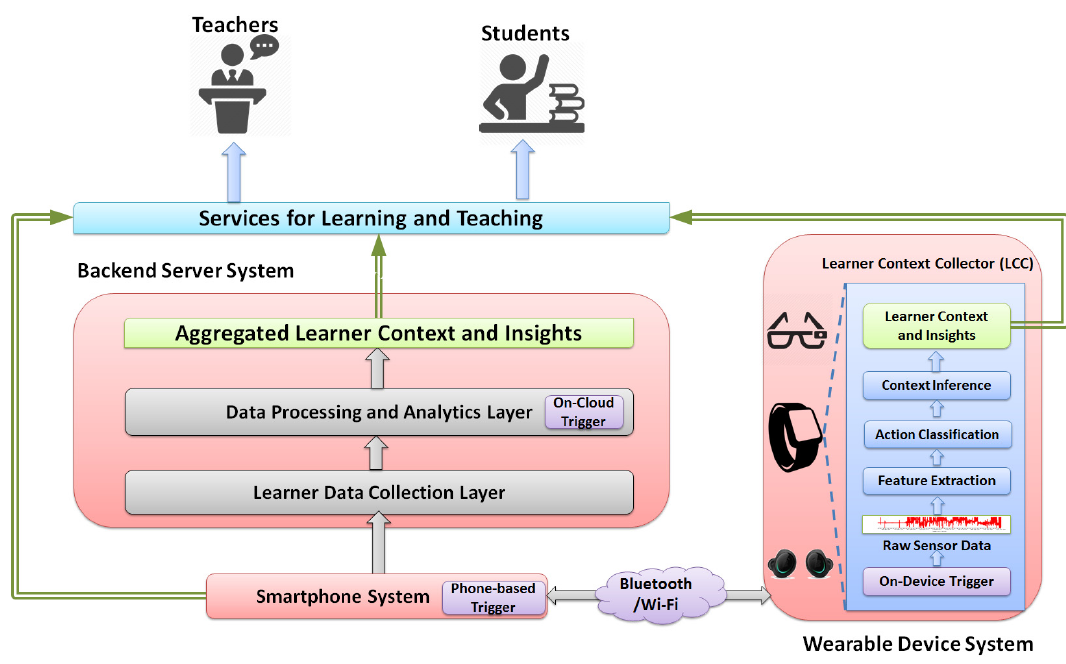
Figure 1. Block diagram of the